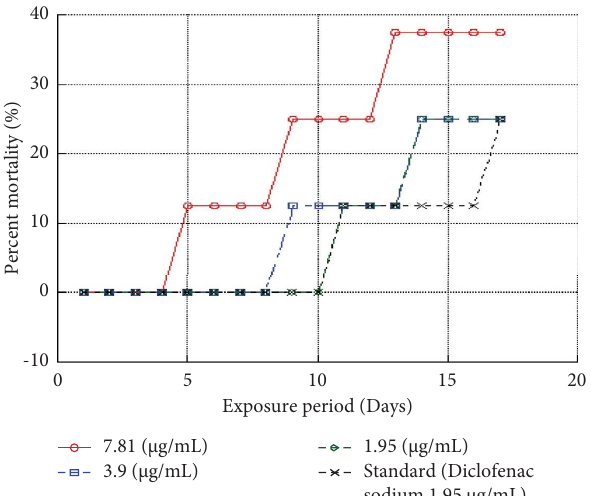
Figure 1: Mortalities recorded during the sublethal test in tadpoles exposed to aqueous extract of Antrocaryon klaineanum for 17days.